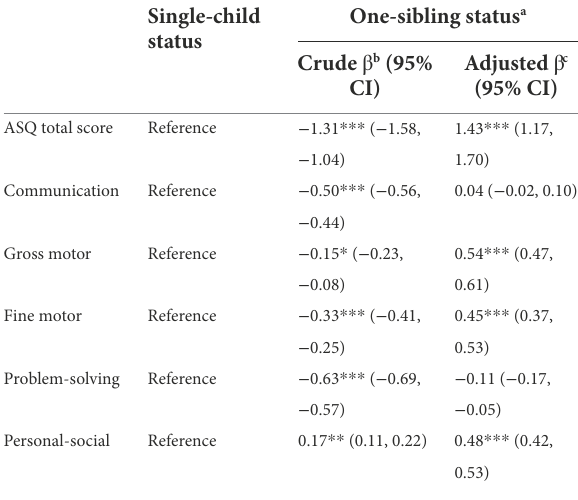
TABLE 3 The association between sibling effect and ASQ-3 scores in preschoolers ( n =